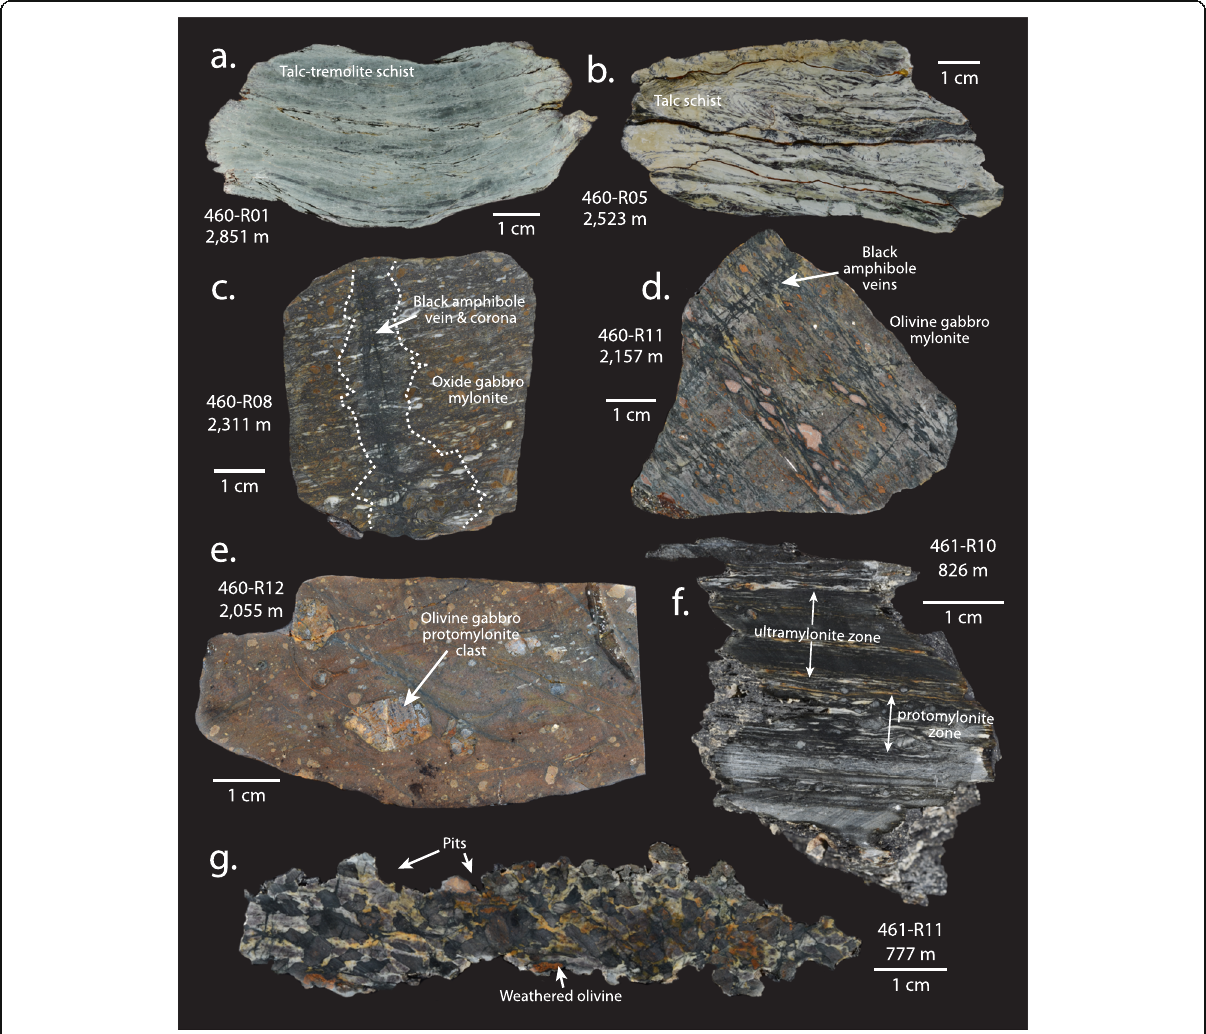
Fig. 39 Representative samples from Shinkai Dives 6K-460 and 6K-461 (Fig. 38): a Talc-tremolite schist. b Talc schist (soapstone). c Partially amphibolitized, oxide gabbro mylonite. Note the centimeter-wide band of orthogonal black amphibole veins and ther albite and black amphibole alteration coronas pseudomorphing the mylonite texture. d Olivine gabbro, amphibolite mylonite with orthogonal black amphibole veins and albite- amphibole reaction coronas. e Cataclasite or mylonite with clasts of olivine gabbro protomylonite. f Ultramylonite or ultracataclasite olivine gabbro (or both) with protomylonite layers. The irregular border is due to preferential sub-aerial weathering. g Deeply weather pitted, amphibolitized, olivine gabbro with weak to moderate crystal-plastic foliation and numerous, late, orthogonal black amphibole